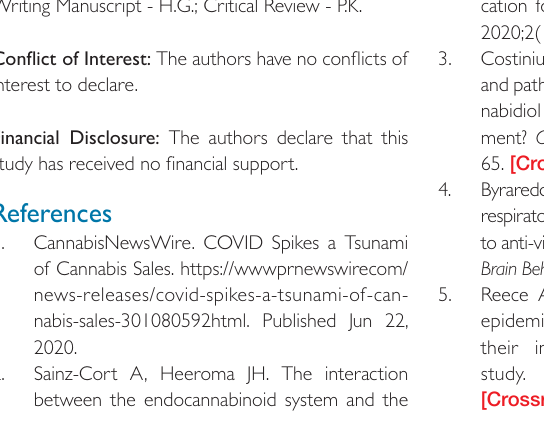
frame of 5 years. Further multicentric phase 3 trials need to be conducted before making these drugs available as potential treatment for